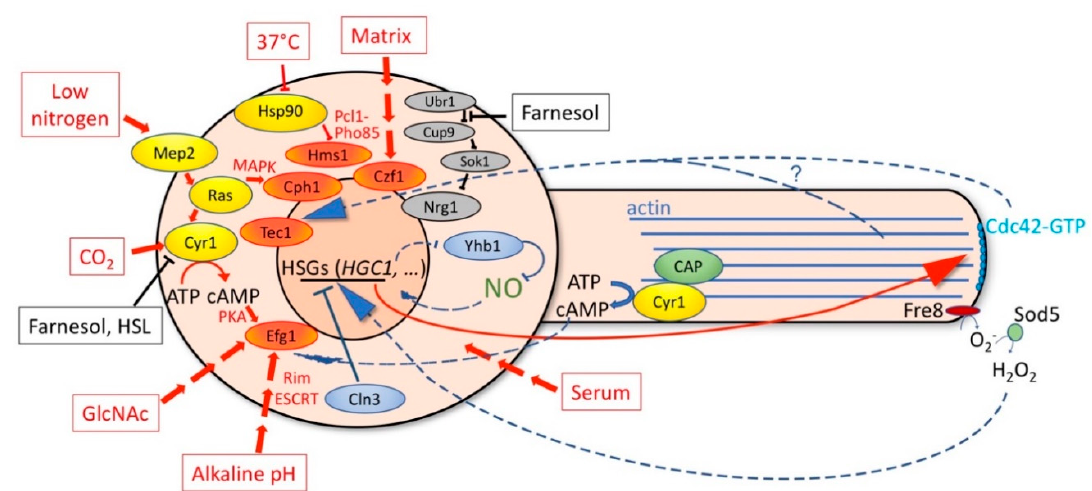
Figure 2. Schematic depiction of some of the positive stimuli on hyphal induction (boxed in red and red arrows) and inhibitory signals (black). The cellular mediators of the hyphal morphogenetic pathways are depicted in yellow ovals and the transcription activators that induce hyphal growth are in orange ovals. The internal signals feeding back from the morphogenetic apparatus (dashed lines) and the cell cycle apparatus (solid lines) to the hypha-specific gene (HSG) expression program are shown in blue. See text for details of the individual interactions. The question mark indicates that it is still unclear whether Cdc42 affects the HSG expression directly or indirectly via its effect on the cytoskeleton.